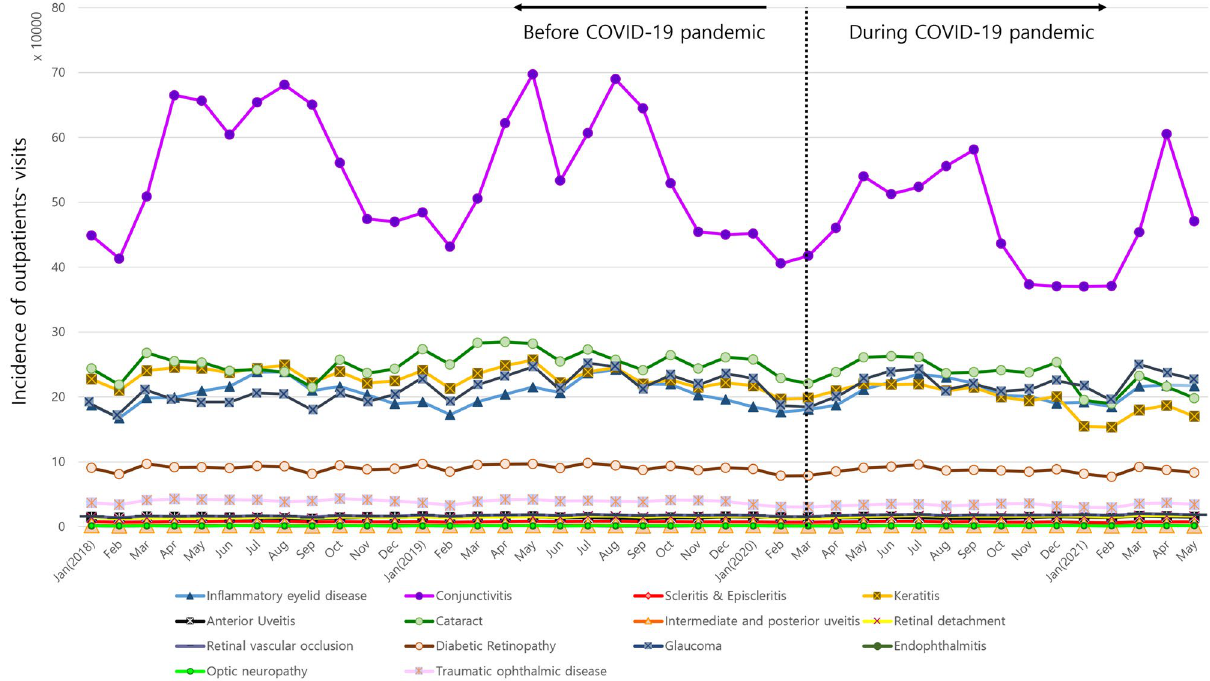
Figure 1. Distribution of various ophthalmic disease incidences (i.e., outpatient visits) before and during COVID-19